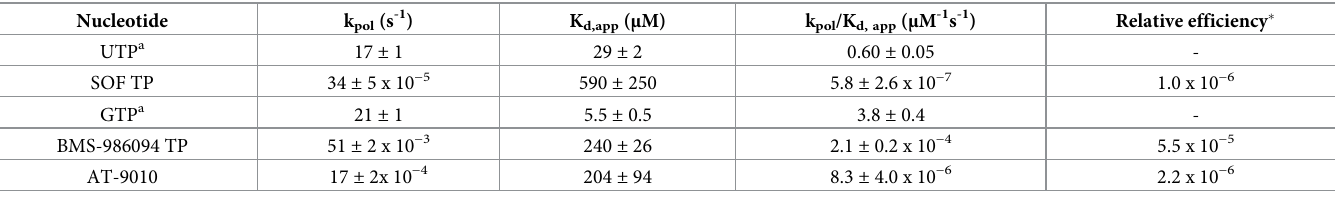
� Relative efficiency is defined as: (k pol /K d,app ) incorrect /(k pol /K d,app ) correct . a Kinetic parameters for the nucleotide controls were taken from